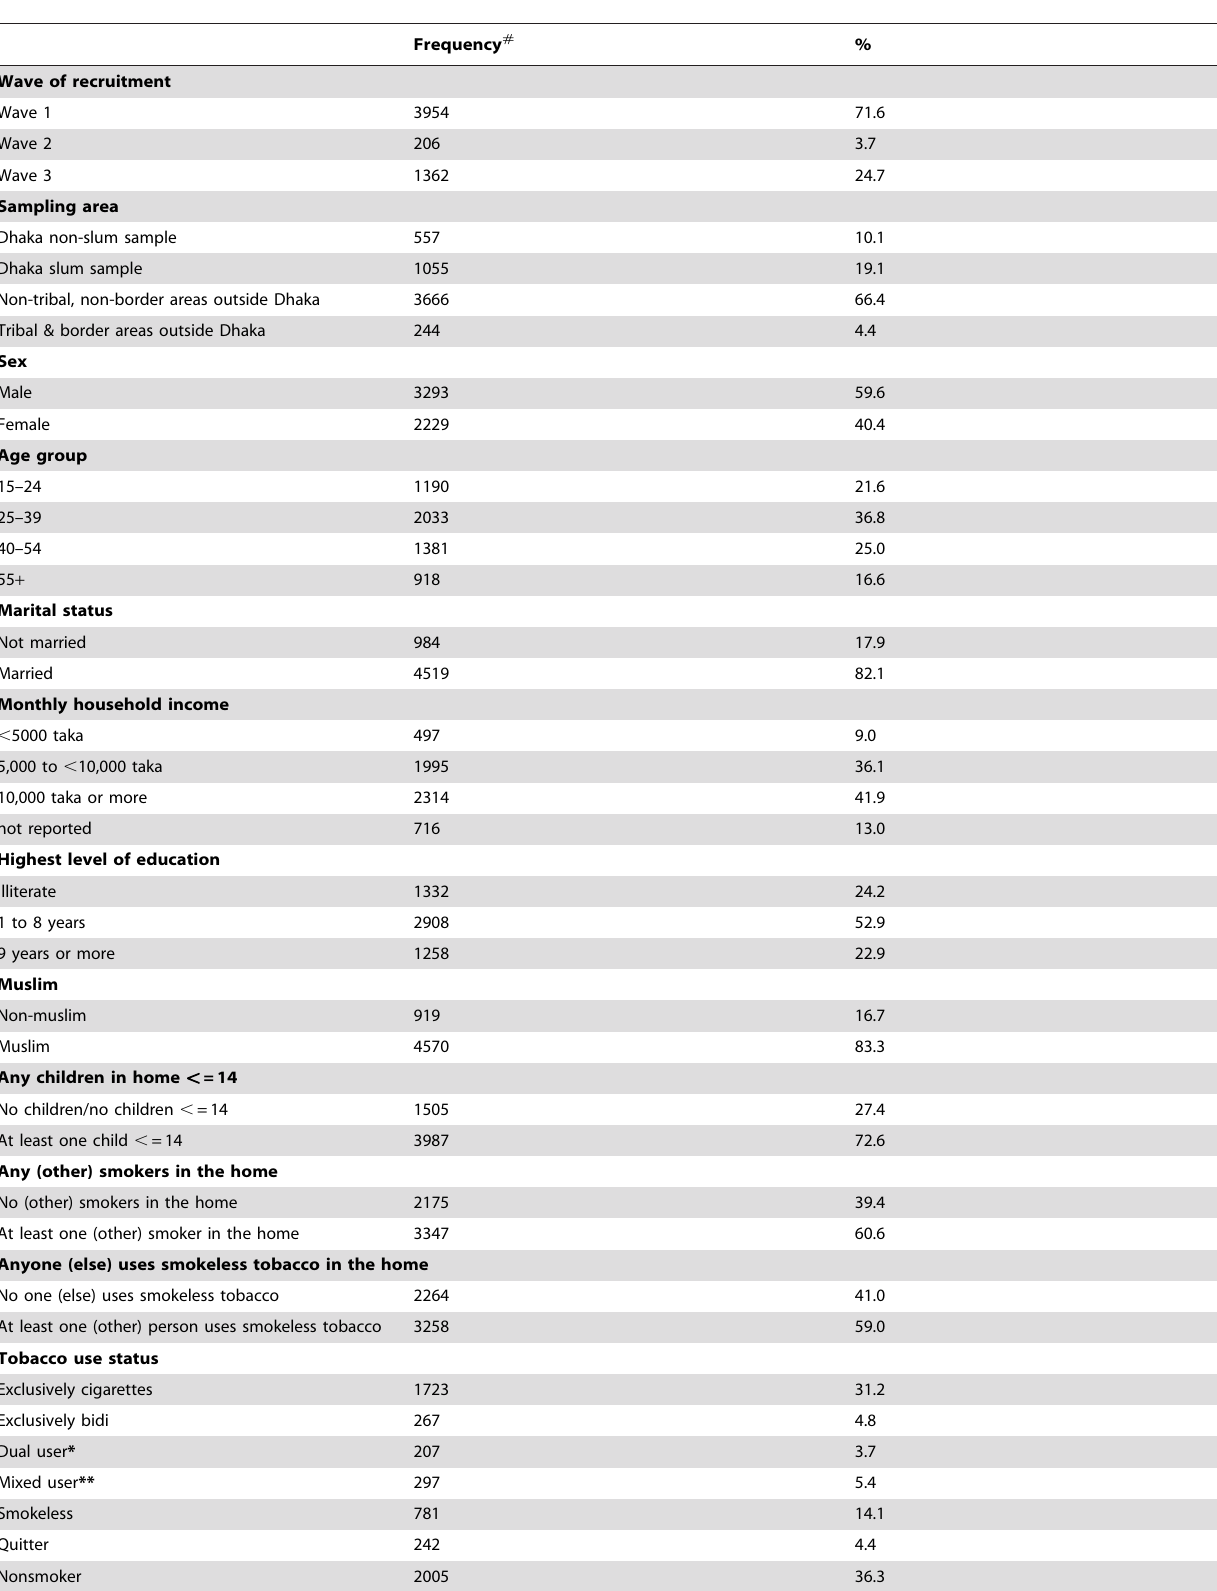
Table 1. Characteristics of the ITC Bangladesh Wave 3 sample (unweighted), Bangladesh 2011 (N =5522).